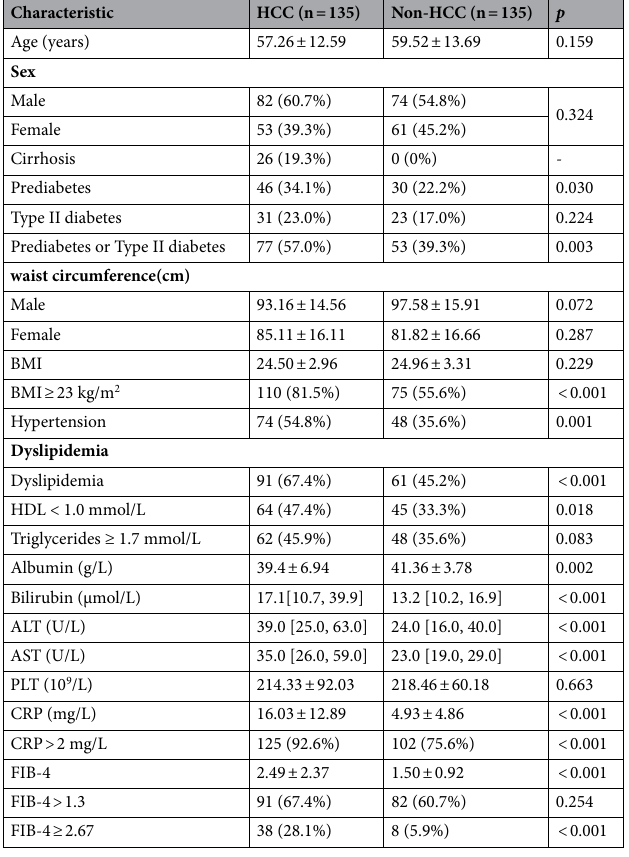
Table 1. Baseline characteristics of patients with MAFLD and MAFLD-HCC. BMI body mass index, HDL high-density lipoprotein, ALT alanine aminotransferase, AST aspartate aminotransferase, PLT platelet, CRP